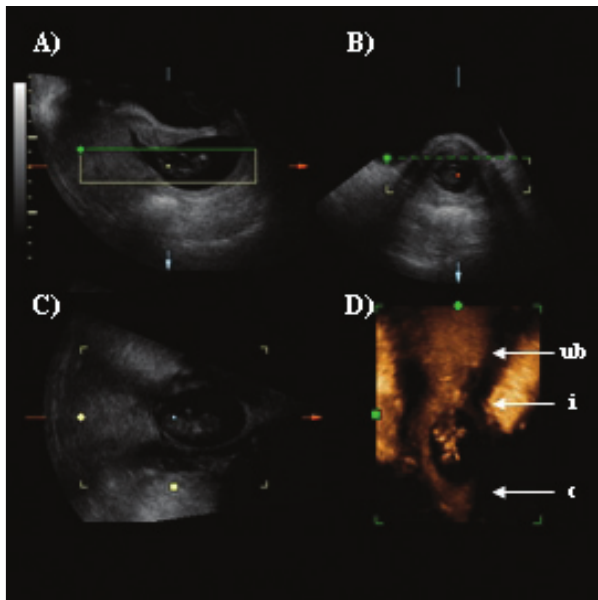
Figure 2 . Multiplanar imaging with the three orthogonal sections: a) sagittal section, b) transversal section, c) coronal section, and d) reconstructed three- dimensional image. The depth of the sectional plane of the render box was adjusted on the A-plane (sagittal section) in order to evaluate the isthmus on the C-plane (coronal section). Note that, on coronal section and on the rendered 3D image, it is possible to delineate the upper limit of the cervical pregnancy at the constricted isthmus (i). ub: uterine body; i: isthmus; c: cervix.